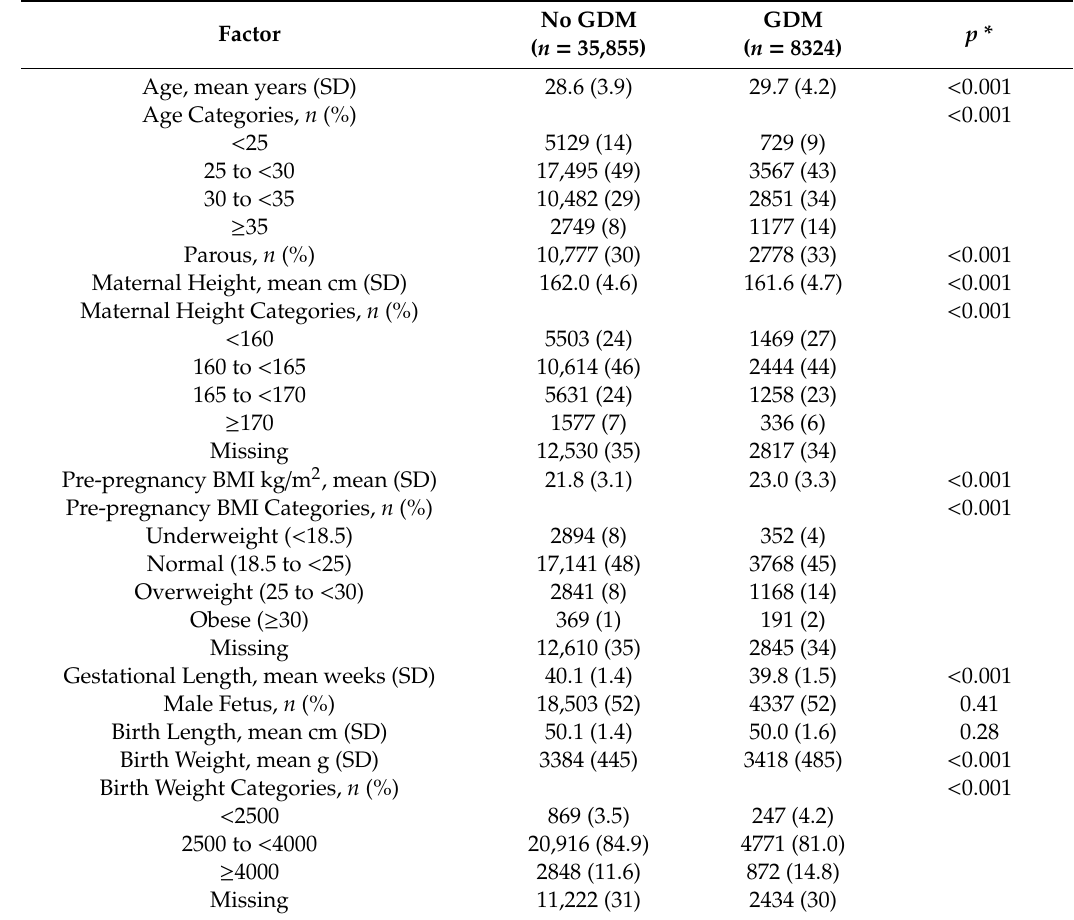
Table 1. Characteristics of the study population by GDM.